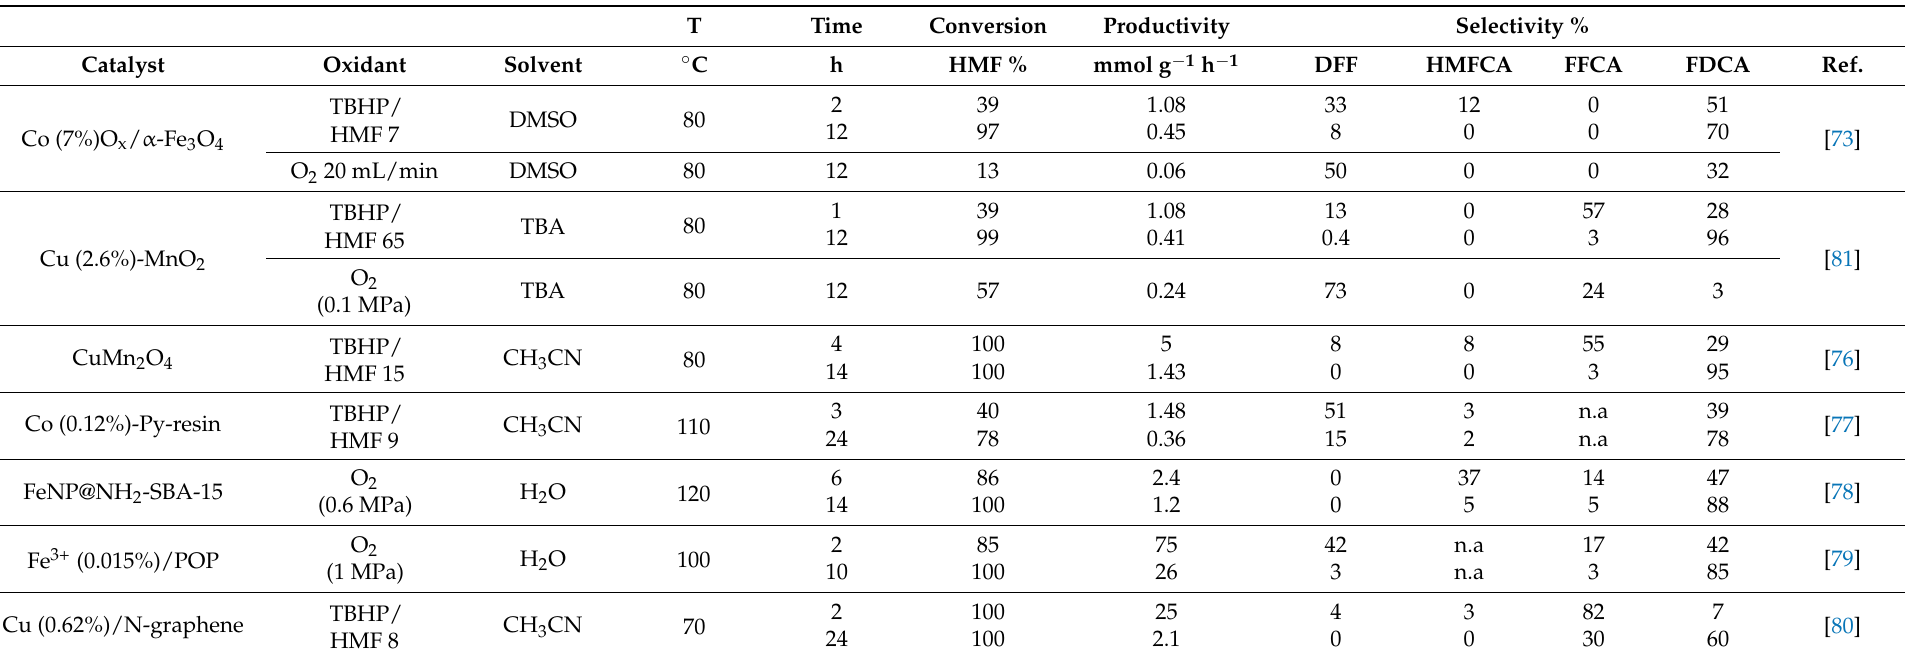
Table 3. Selected literature results of HMF oxidation on non-noble metal